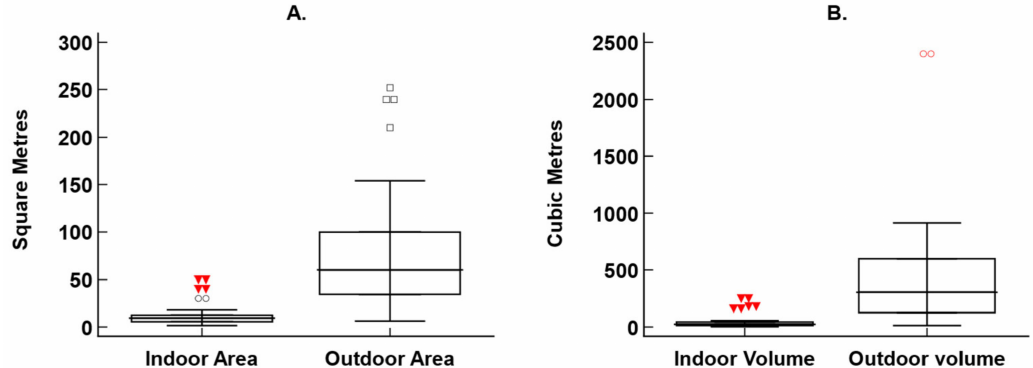
Figure 2. Variation in space provided to individual fossa across sample zoos that provided data on indoor and outdoor ( A ) area in square metres (length × width) and ( B ) volume in cubic metres (length × width × height).